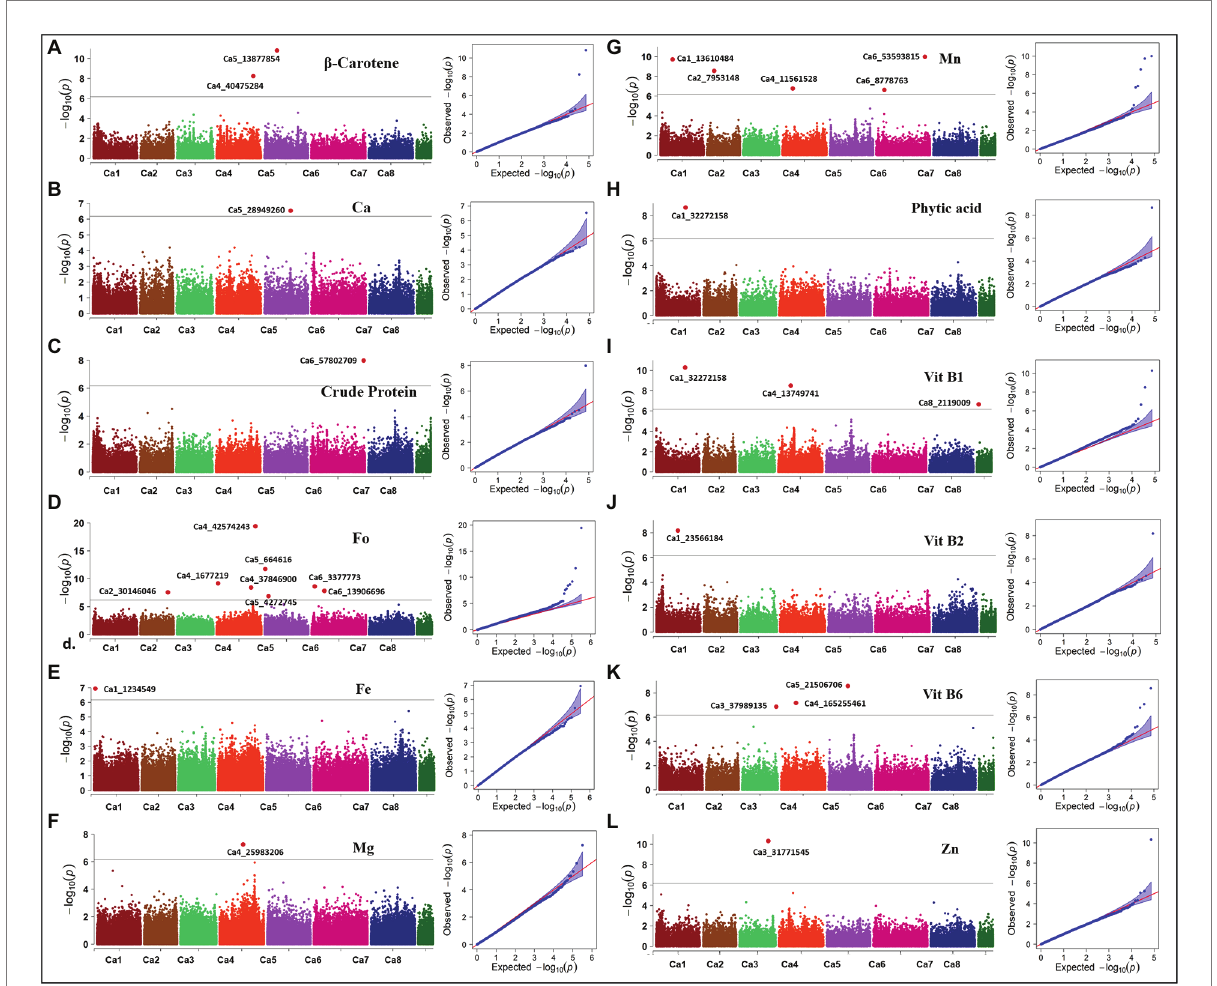
FIGURE 5 Manhattan plots and Q-Q plots showing association in the diverse reference set for 12 nutritional traits. Manhattan and QQ-plots depicted for (A) β -Carotene, (B) calcium (Ca), (C) crude protein, (D) folate (Fo), (E) iron (Fe), (F) magnesium (Mg), (G) manganese (Mn), (H) phytic acid, (I) vitamin B1 (Vit B1), (J) vitamin B2 (Vit B2), (K) vitamin B6 (Vit B6), and (L) zinc (Zn). Associations were detected with 73,968 SNPs using the BLINK method for all traits except Fe and Mg; associations for Fe and Mg were detected with 318,644 SNPs using the MLMM method. Black solid line indicates Bonferroni threshold at 5% level, above which significant associations are depicted as red